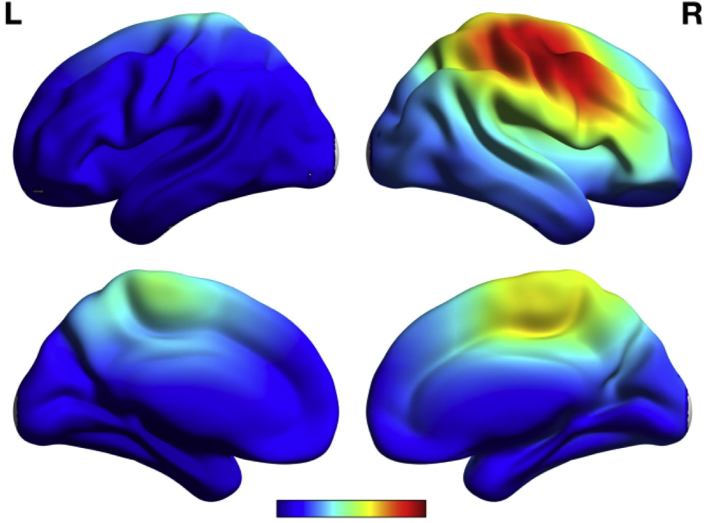
Electrical source imaging. Average current density distribution across patients shows higher activity at the central region of the epileptic zone. Source imaging was estimated for signals for 200 ms before and after the spike.